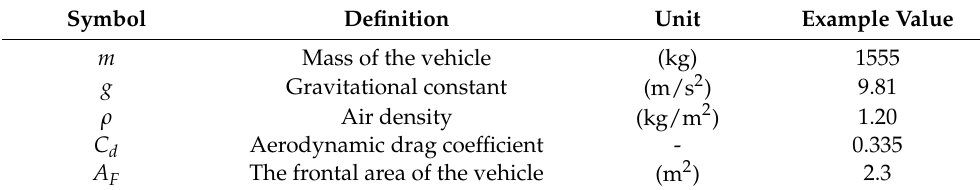
Table 1. Parameters notations of the vehicle dynamic